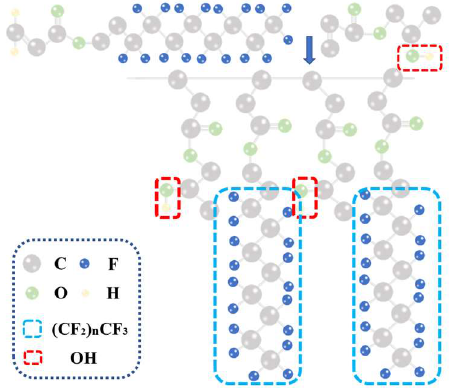
Figure 1. C synthesis reaction equation.